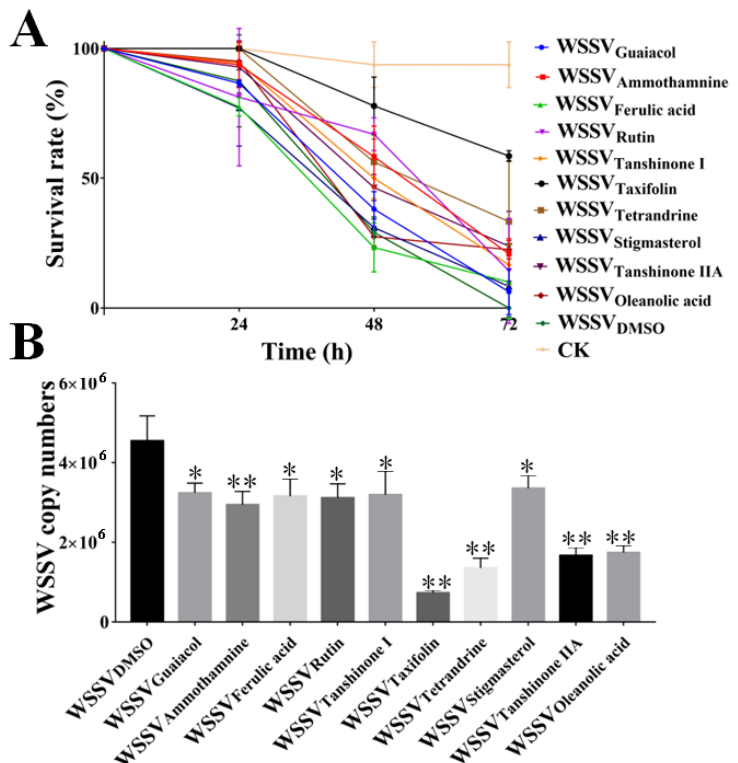
Figure 2. Anti-WSSV activity of taxifolin was the best. ( A ) Survivorship curves of shrimp larvae were co-incubation with active small molecules (safe concentration) and WSSV for 72 h. ( B ) The copy number of WSSV genome was detected by qPCR at 72 h. Each value was represented as the mean ± SD. The p value was determined by Student’s t -tests. ** p < 0.01; * p < 0.05.